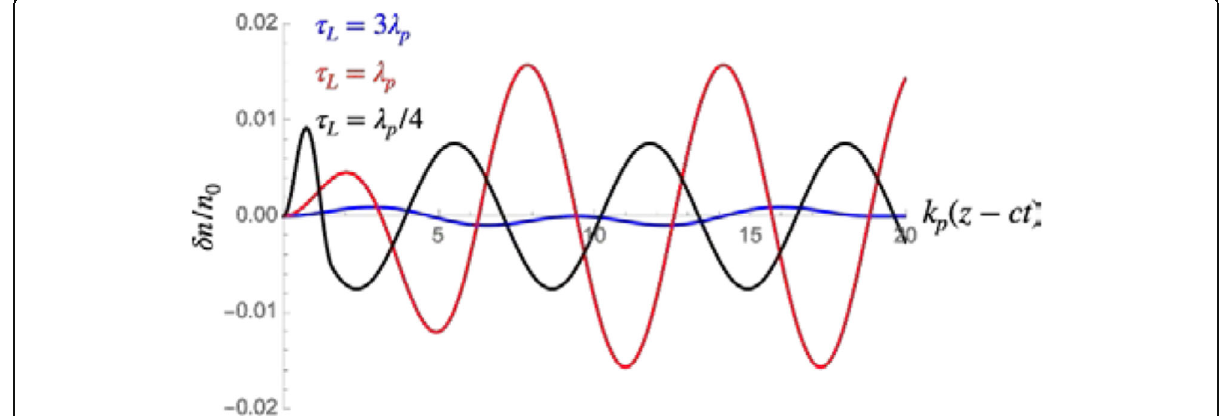
Fig. 11 Density modulation excited after the laser pulse for three values of pulse length, c τ L = λ p /4 (black), λ p (red), and 3 λ P (blue). k p = ω p /